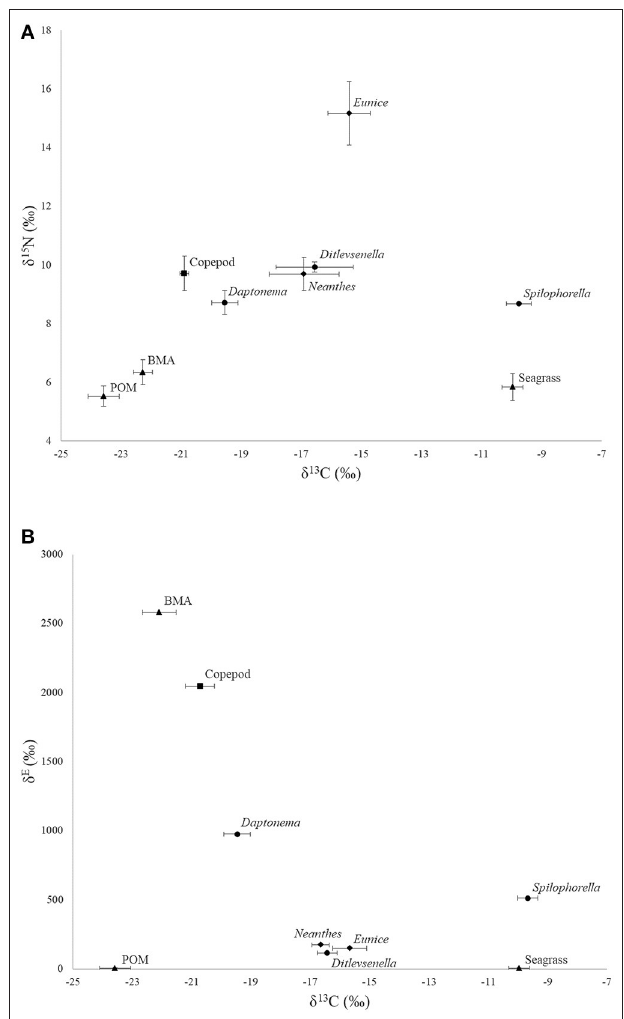
FIGURE 2 | (A) Natural abundance stable isotope bi-plot ( δ 15 N and δ 13 C; prior to isotope addition, data from Xu et al., 2018) and (B) 15 N-addition ( δ E ) stable isotope values of primary producers and consumers during the 21-day experiment plotted against average δ 13 C ( ± SD) values over the 21-day study. Nematodes are shown in circles, copepods in squares, polychaetes in diamonds, and primary producers in triangles.